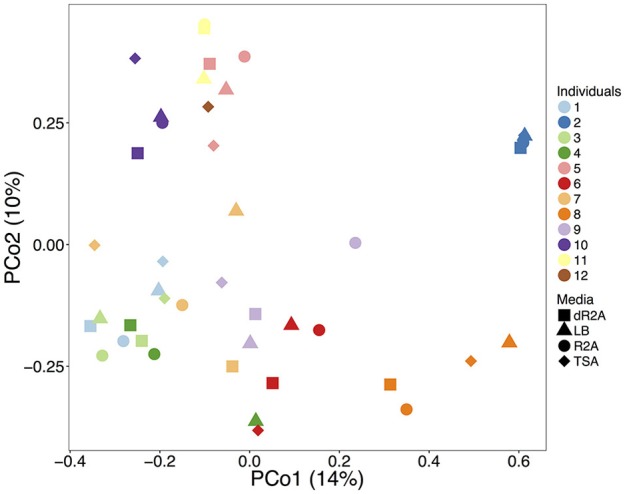
Beta diversity comparisons of the cultured bacterial communities using a principal coordinate analysis (PCoA) ordination based on Bray-Curtis dissimilarity distances. Points represent each plated community. Colors and shapes represent individual toads and culture media types, respectively.